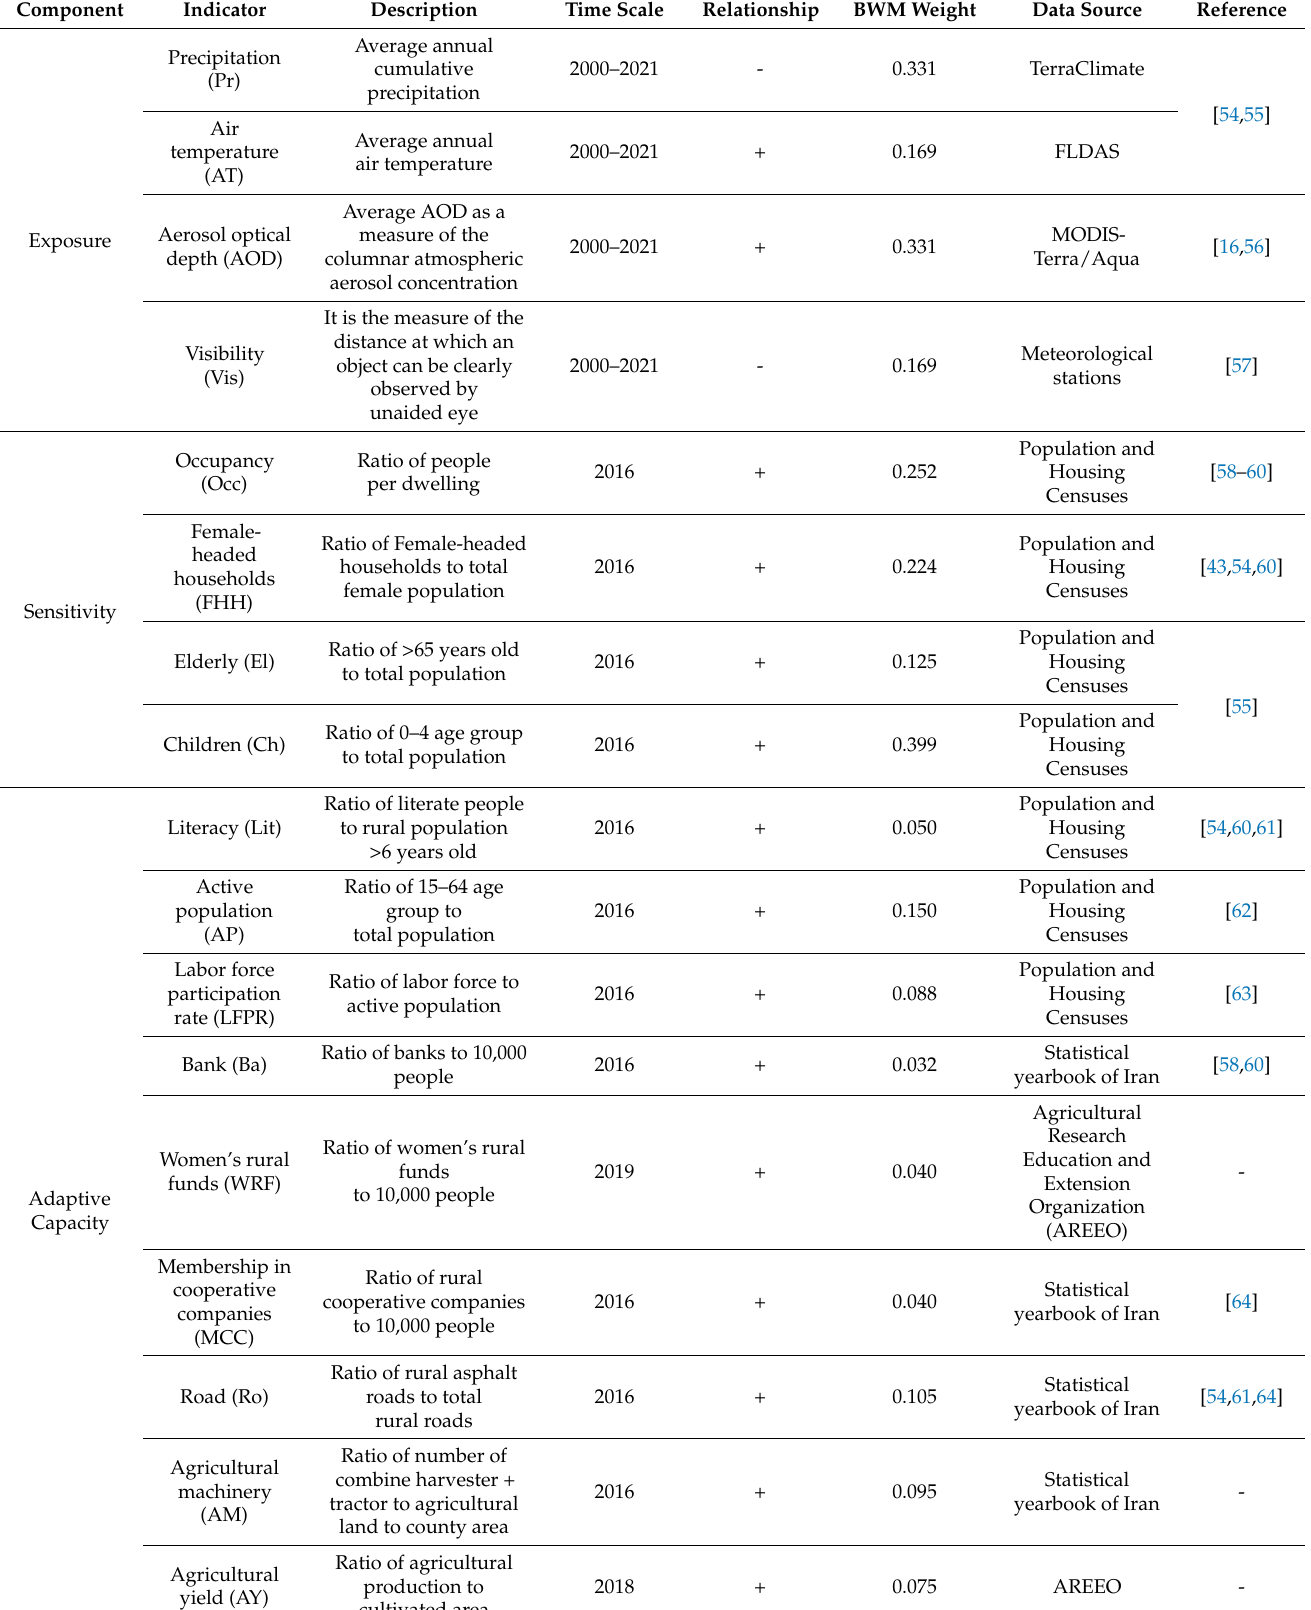
Table 1. Components and corresponding indicators for assessing vulnerability of rural areas to